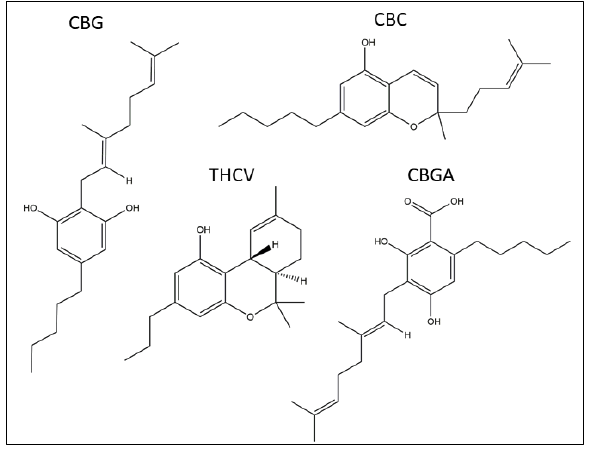
Figure 1. Chemical structures of the four pCBs under study: cannabigerol (CBG), cannabichromene (CBC), ∆ 9 -tetrahydrocannabivarin (THCV) and cannabigerolic acid (CBGA).